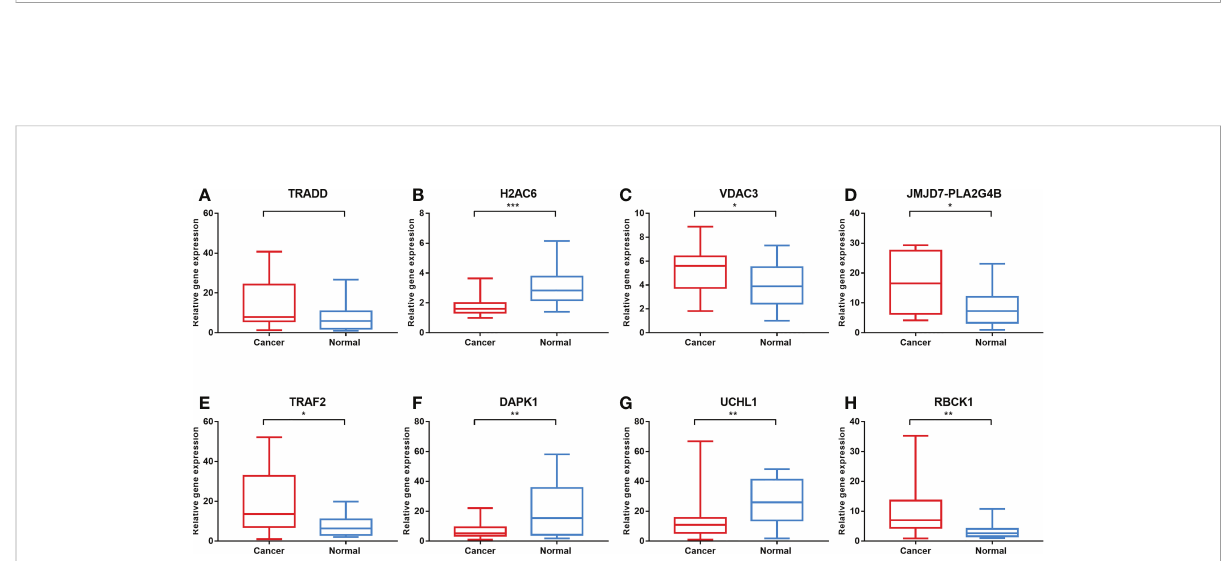
FIGURE 11 Validation of gene expression in tissues via qRT-PCR. The expression of eight necroptosis-related genes [ TRADD (A) , H2AC6 (B) , VDAC3 (C) , JMJD7-PLA2G4B (D) , TRAF2 (E) , DAPK1 (F) , UCHL1 (G) , RBCK1 (H) ] in the normal and cancer tissues. * P < 0.05, ** P < 0.01, *** P < 0.001. qRT- PCR, quantitative real-time polymerase chain